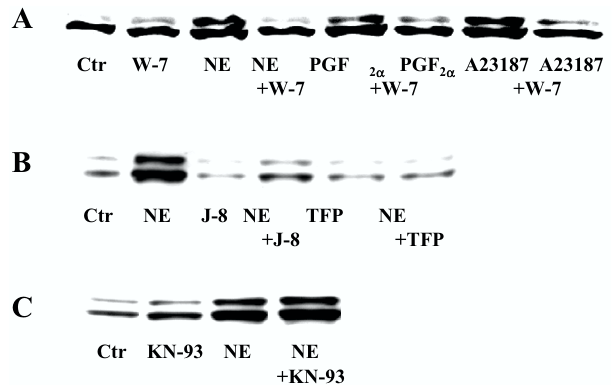
Figure 6 Immunoblots showing the effect of inhibitors of calmodulin (W-7, J-8, trifluoperazine) and the multifunctional Ca 2+ /cal- modulin dependent protein kinase (KN-93) on ERK1/2 acti- vation (A-C). Hepatocytes were cultured for 3 h before preincubation for 30 min with timolol (10 µ M) A: in the pres- ence or absence of W-7 (25 µ M) before stimulation for 5 min with norepinephrine (10 µ M), PGF 2 α (10 µ M) or A23187 (10 µ M) or B, C: with or without J-8 (40 µ M), trifluoperazine (50 µ M) or KN-93 (20 µ M) before 5 min of stimulation with norepinephrine (10 µ M). Western analyses were based on the use of antibody against dually phosphorylated